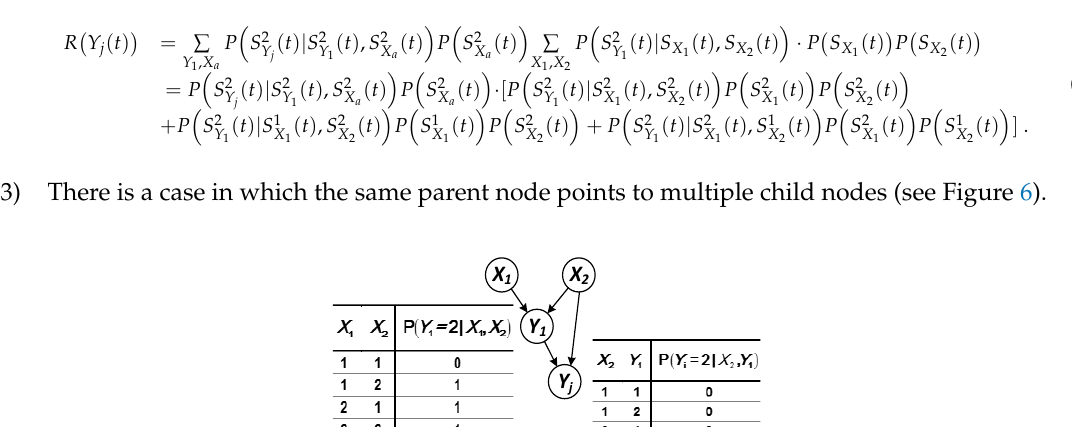
Figure 5. Logical structure in which the parent node contains both the intermediate and root nodes.